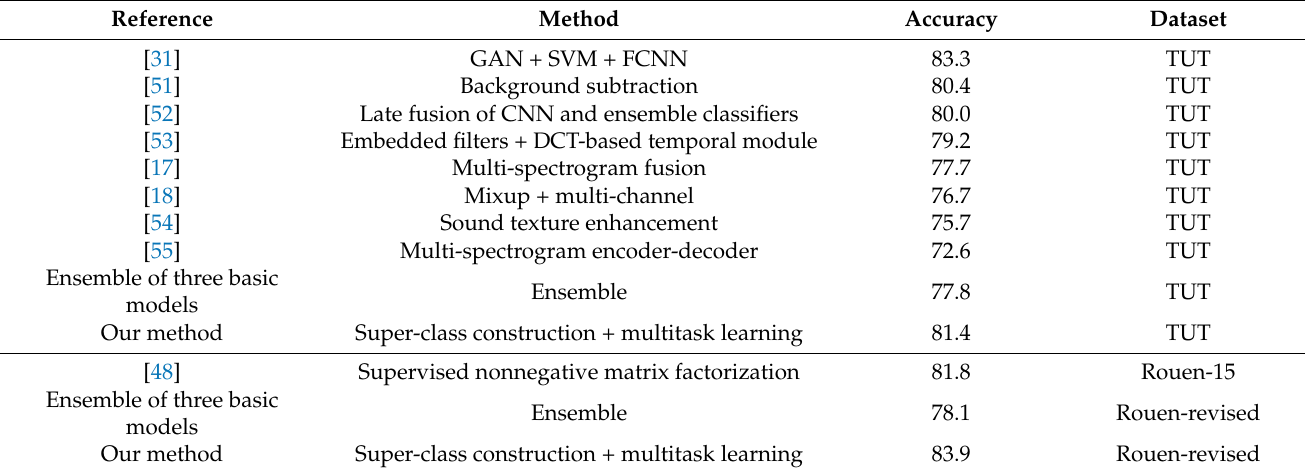
Table 6. Comparison of accuracies with state-of-the-art